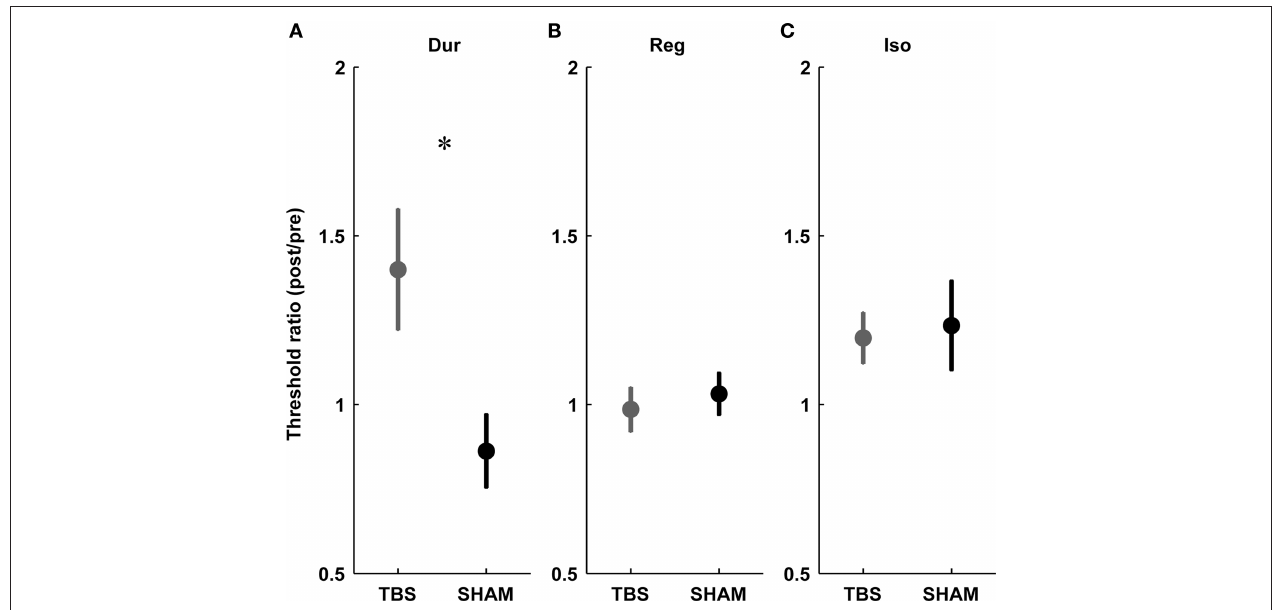
Figure 3 | Threshold ratios for the three timing tasks in the TBS (gray) vs. SHAM (black) group. (A) Duration discrimination for single intervals (Dur), (B) regularity detection (Reg), (C) detection of a deviation from isochrony (Iso). Plots show mean ± SEM. Note the significant difference between TBS and SHAM exclusive to single-interval duration discrimination (A)